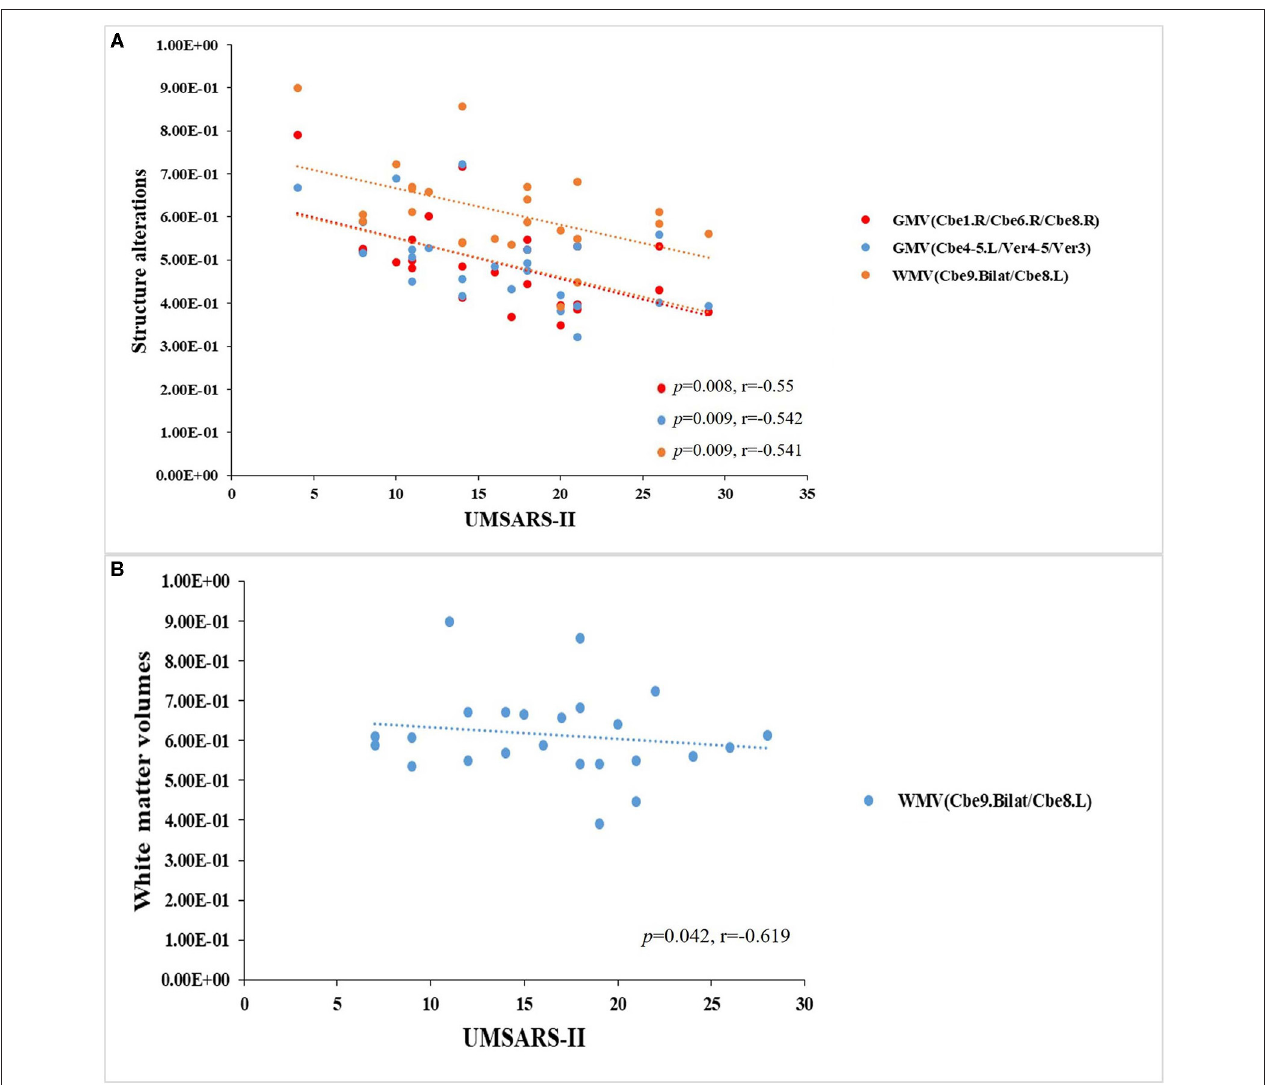
FIGURE 4 | Relationships between clinical variables and multimode MRI parameters in patients with MSAc and MSA-p type, respectively. (A) In the MSA-c type group, we found significant negative correlations between the UMSARS -II scores and structure changes. (B) In the MSA-p type group, we found a negative correlation between the UMSARS -I scores and WM